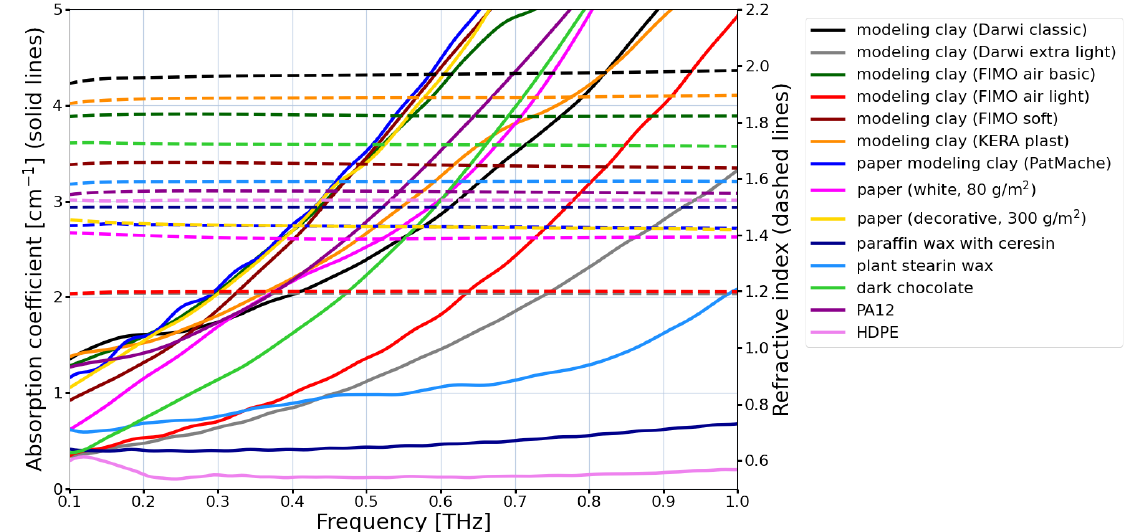
Figure 3. Refractive indices and absorption coefficients of alternative THz optical materials. Different types of modelling clay with refractive index values ranging from 1.2 up to 2, papers, paraffin, chocolate. HDPE and PA12 are plotted as reference